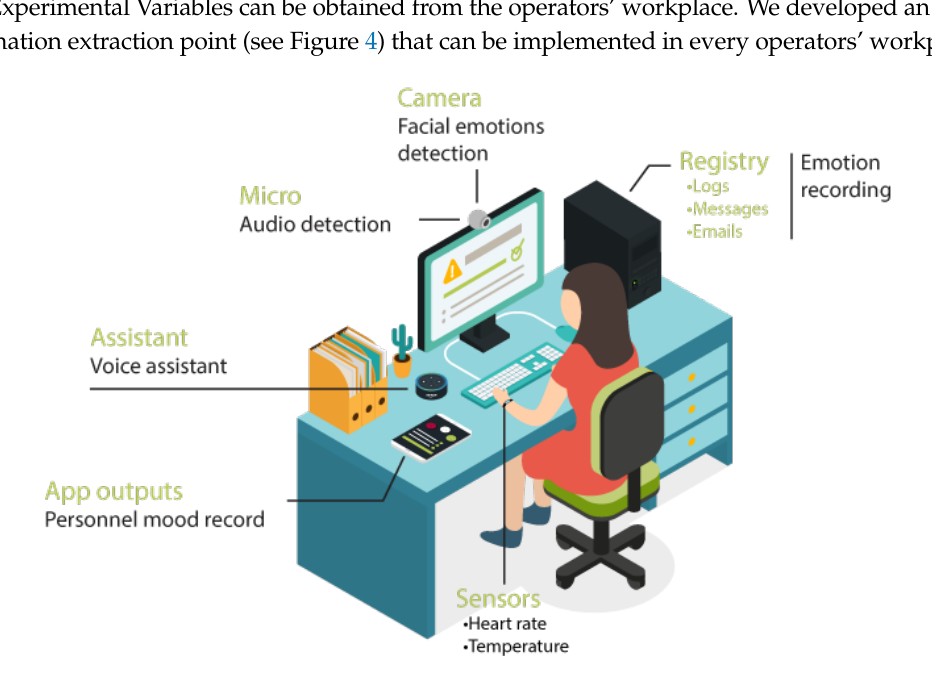
Figure 4. Employee Information Extraction